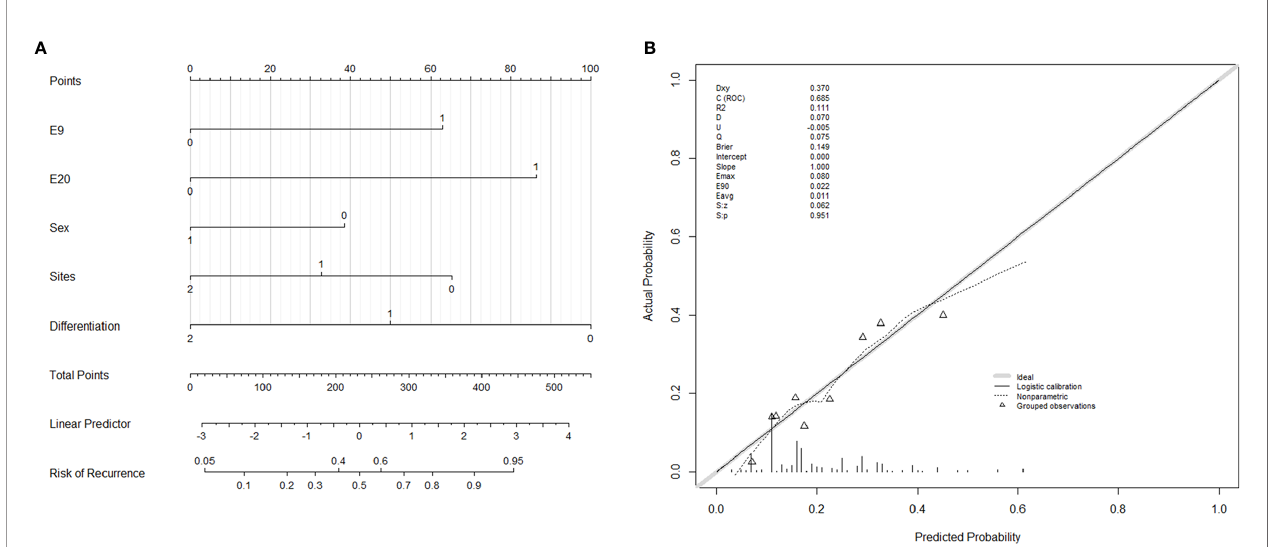
FIGURE 3 | Nomogram and calibration curves for predicting the probability of disease recurrence in Stage III CRC patients. (A) E9: PIK3CA exon 9, 0 = wild-type, 1 = mutation; E20: PIK3CA exon 20, 0 = wild-type, 1 = mutation; Sex: 0 = female, 1 = male; Sites: tumor sites, 0 = rectum, 1 = left colon, 2 = right colon; Differentiation: tubular adenocarcinoma differentiation, 0 = poor differentiation, 1 = moderate differentiation, 2 = well differentiation. (B) Calibrate curve of nomogram. The C-index of this nomogram is